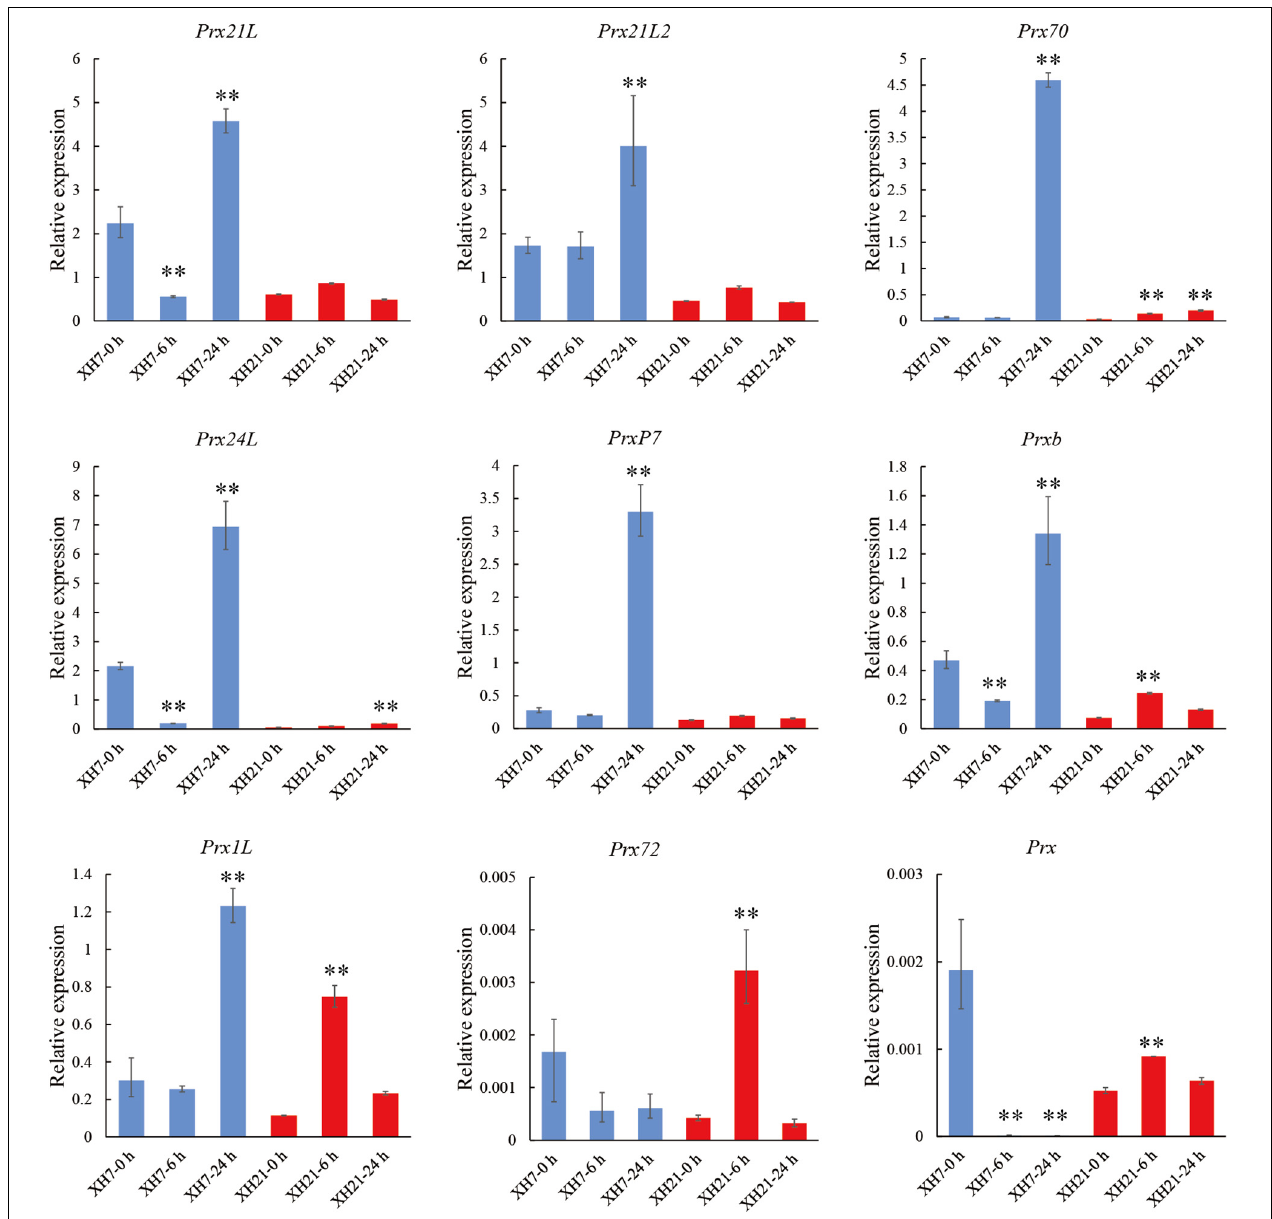
FIGURE 2 | Transcriptional expression analysis of nine peroxidases. Relative expression levels of nine peroxidases identified in GO enrichment analysis. GbUBQ was used as an internal control and set to 1. Three independent replicates were performed for each PCR assay. ∗∗ p <